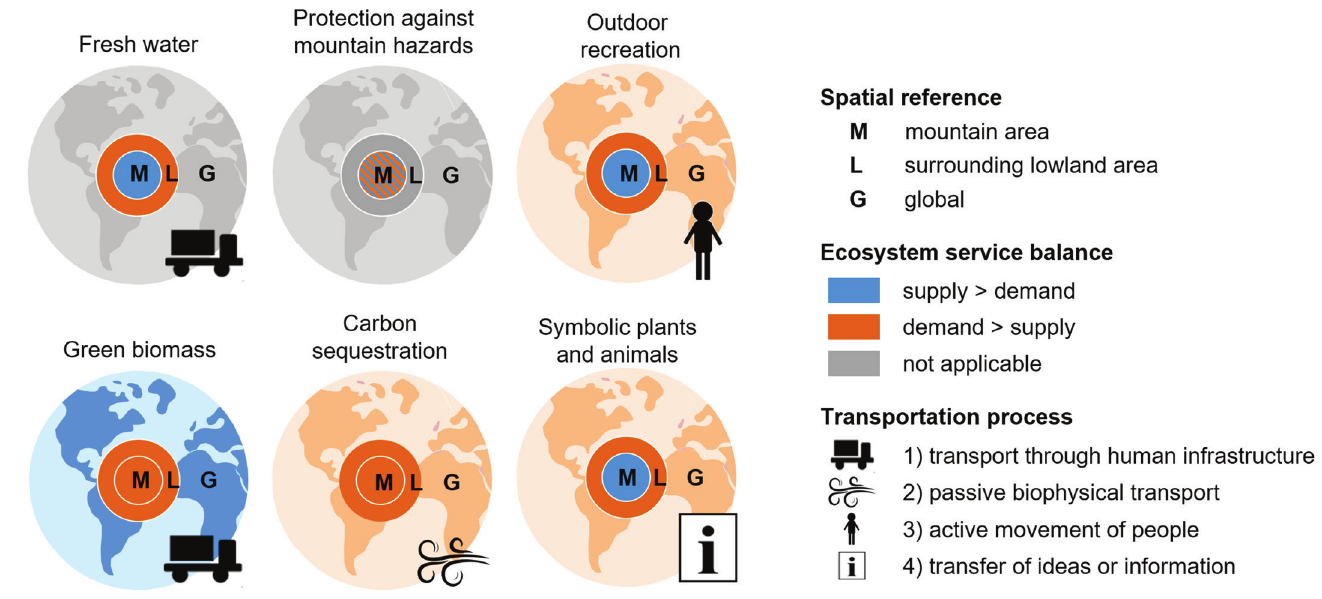
Figure 6. Generalized schemes of ES transfer. The colours indicate for each zone whether it is a service-providing (supply > demand) or a service-demanding area (demand > supply). The symbols represent different types of transportation processes (1–4). From Schirpke et al.